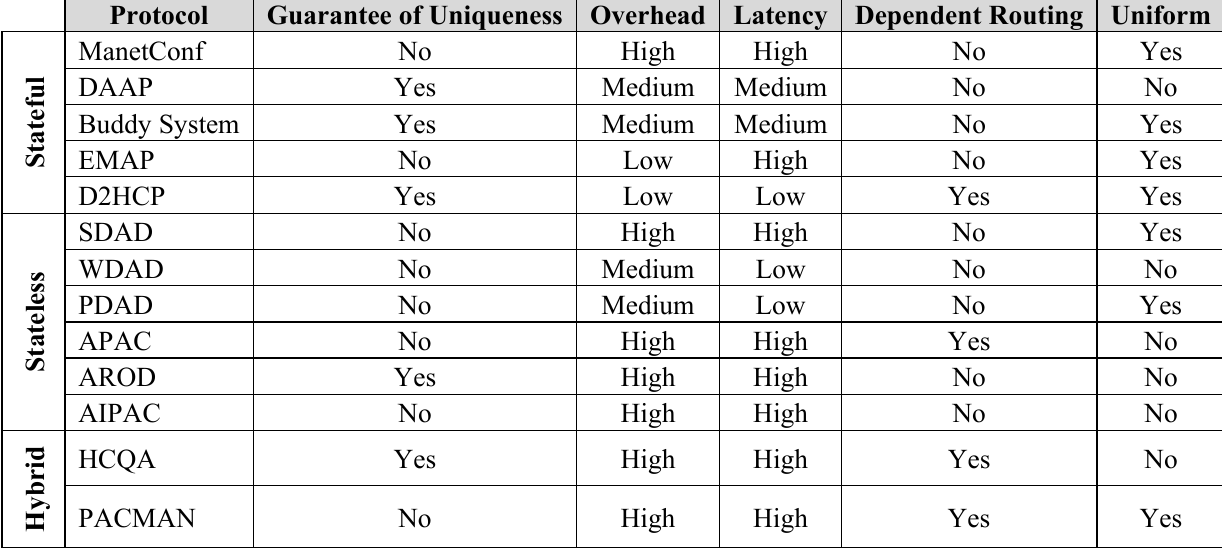
Table 2. Comparison of the characteristics of IPv4 addressing